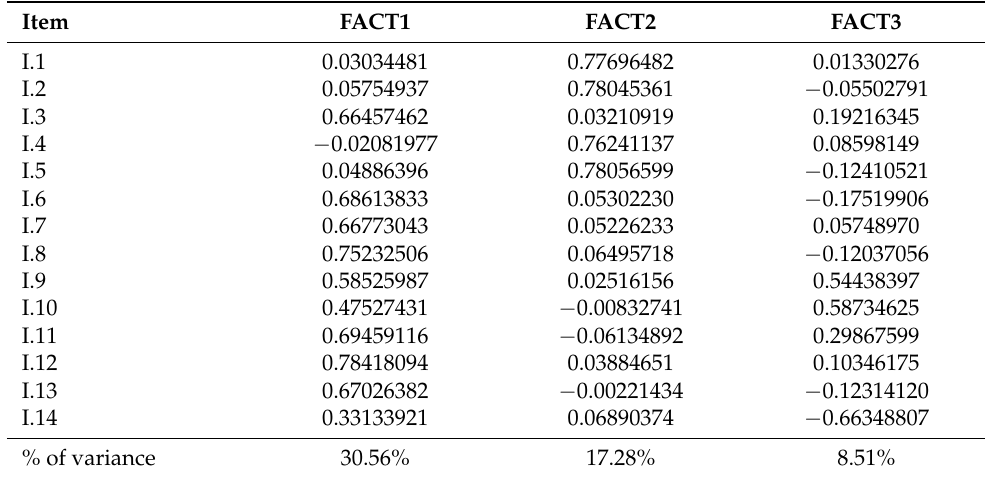
Table 5. Factor matrix with varimax rotation for WhatsApp Indian data.